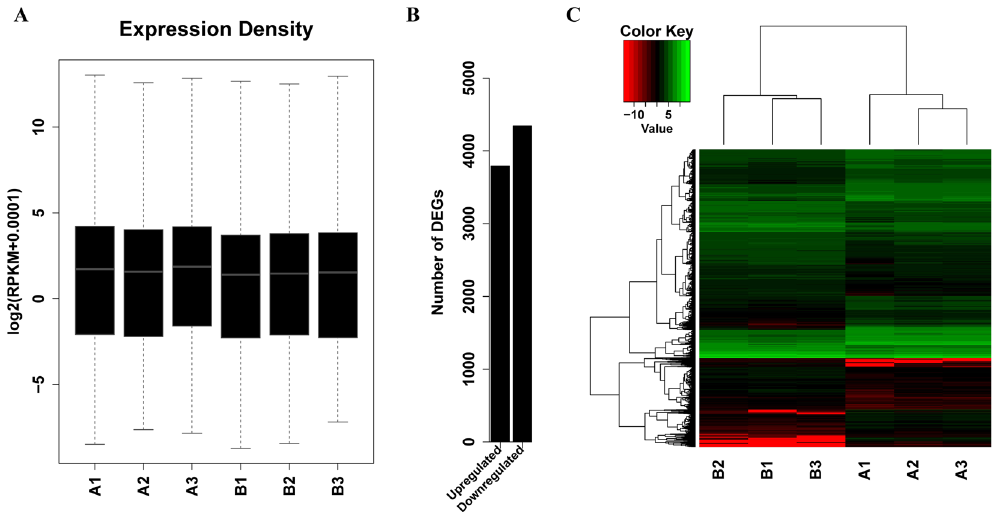
Figure 2. Differentially expressed mRNAs in PVY-infected and mock-inoculated tobacco plants. ( A ) Gene density of mRNAs in the PVY-infected (three biological replicates: A1, A2, A3) and mock-inoculated (three biological replicates: B1, B2, B3) tobacco RNA libraries; ( B ) Total numbers of up-regulated and down-regulated DEGs; ( C ) Differentially expressed mRNAs in PVY-infected (A1, A2, A3) and mock-inoculated (B1, B2, B3) tobacco. Every row shows a different gene. Red, black and green indicates expression levels of mRNA slow, medium and high,